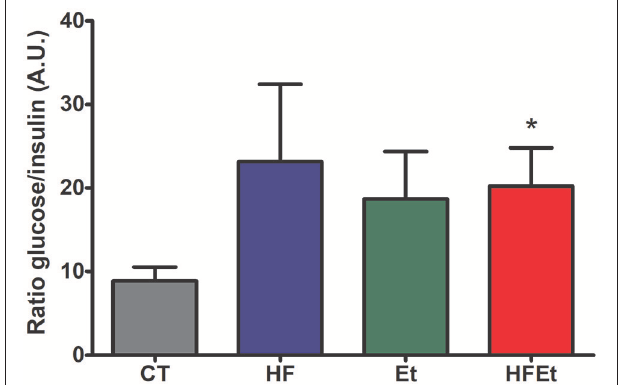
FIGURE 2 | Ratio glycemia/insulinemia in rats after 6-week diet with either control (CT), high fructose (HF), ethanol (Et), or a mix diet (HFEt) and prior infusion of [1- 13 C]D-glucose. Glucose and insulin content were measured in a blood sample collected just before [1- 13 C]glucose infusion and after 6 weeks of diet to detect any disturbance in insulin and therefore glucose metabolism homeostasis at this time point. Values are mean ± SEM. *Statistical difference between CT and HFEt.